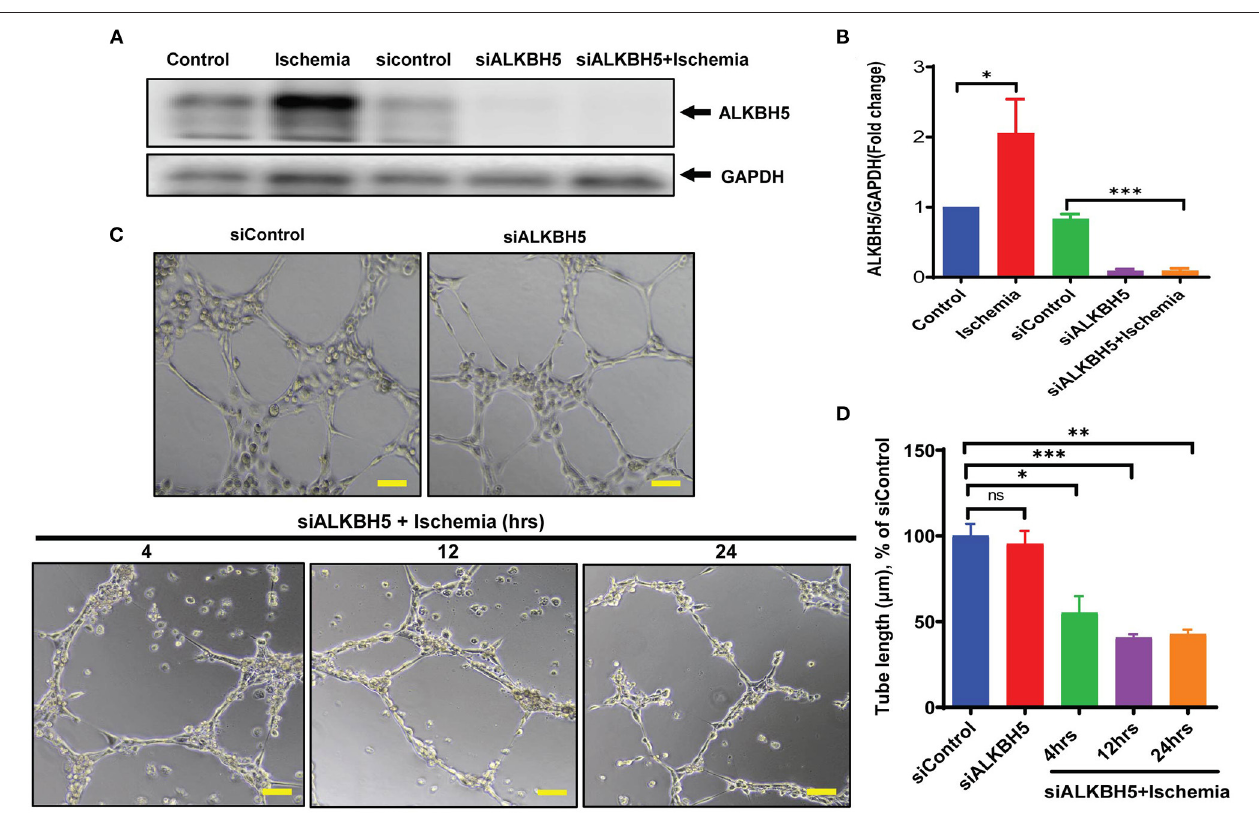
FIGURE 3 | ALKBH5 silencing impaired the tube formation in ECs. (A) HMVE cells were transfected with 10nM siALKBH5 siRNA for 18 h before ischemic stimulus. Scrambled RNA was used as a negative control. (B) WB quantification revealed an increased expression of ALKBH5 following treatments. ALKBH5 silencing inhibits ischemic stress induced ALKBH5 expression. * P < 0.05, control vs. 24 h ischemic stress; *** P < 0.001, siRNA negative control vs. siALKBH5; (C) HUVEC cells were treated with ischemic stress following ALKBH5 silencing. Cells were trypsinized and seeded on matrigel. (D) Tube formation was observed under the microscope at 100X magnification and tube length was measured with ImageJ (NIH) software (total 40–50 branch points were measured to take the average for each specimen). The scale bar on Image represents 50 µ M pixel size. * P < 0.05, siRNA negative control vs. siALKBH5 with 4 h ischemia; *** P < 0.001, siRNA negative control vs. siALKBH5 with 12 h ischemia; ** P < 0.01, siRNA negative control vs. siALKBH5 with 24 h ischemia; ns indicates not significant ( n =